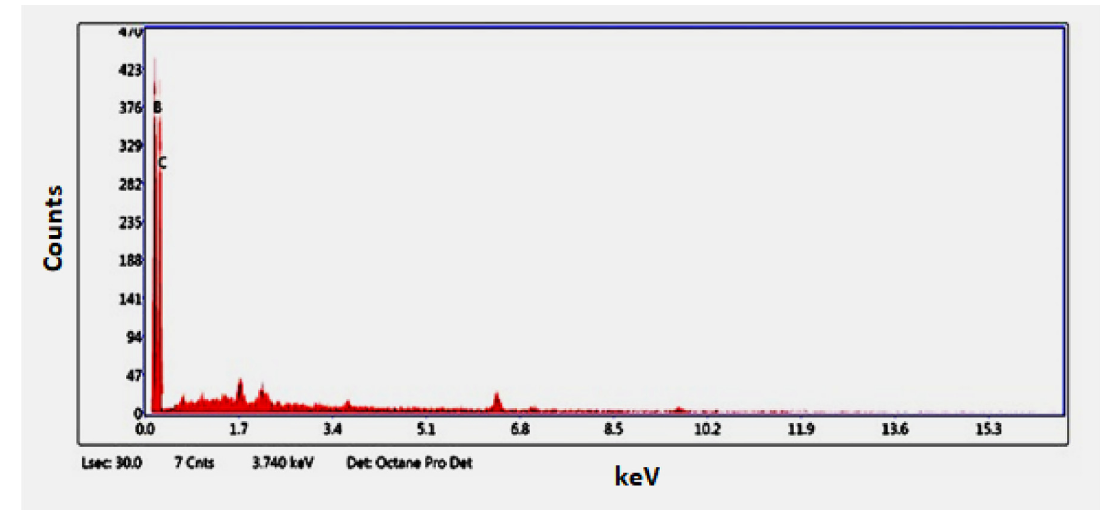
Fig. 2. EDS spectrum of B 4 C particles.